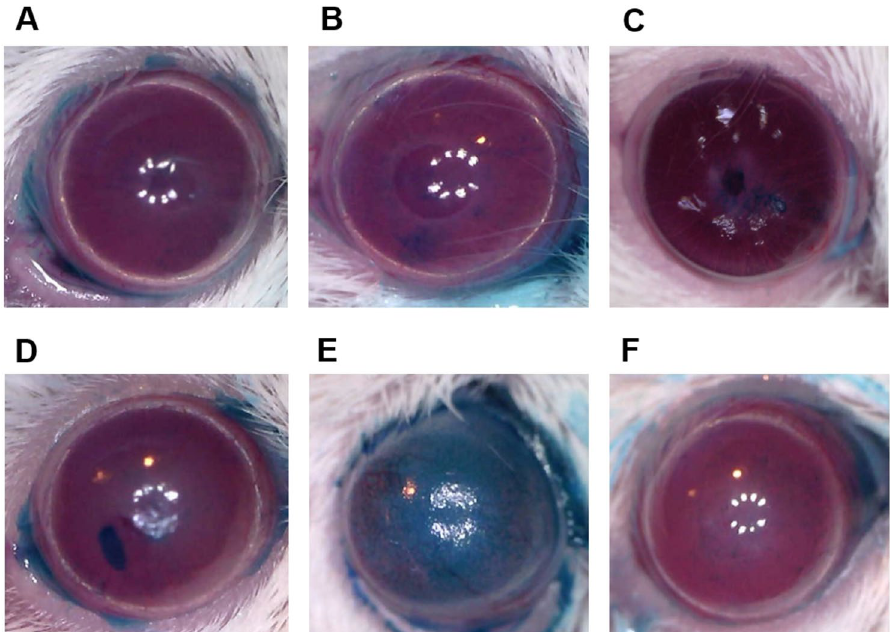
Figure 1. Clinical images of mouse corneas 1 week after treatment of ocular alkali burn model with topical 8-oxo-2 ′ -deoxyguanosine (8-oxo-dG) or corticosteroid. 8-oxo-dG ( A ) 50 mg/mL and ( B ) 10 mg/mL, ( C